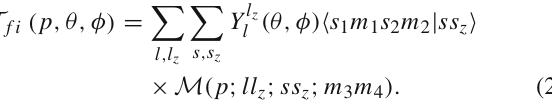
Fig. 1 Sommerfeld ladder diagram for the annihilation of (cid:2) into Stan- dard Model